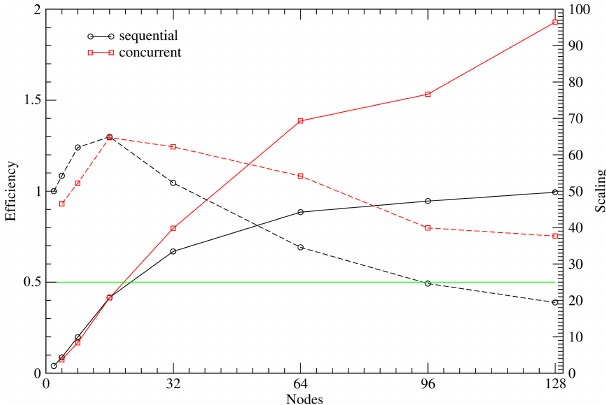
Figure 14. Scaling (solid line) and parallel efficiency (dashed line) for the 40km sequential and concurrent setups. The 0.5 efficiency line is